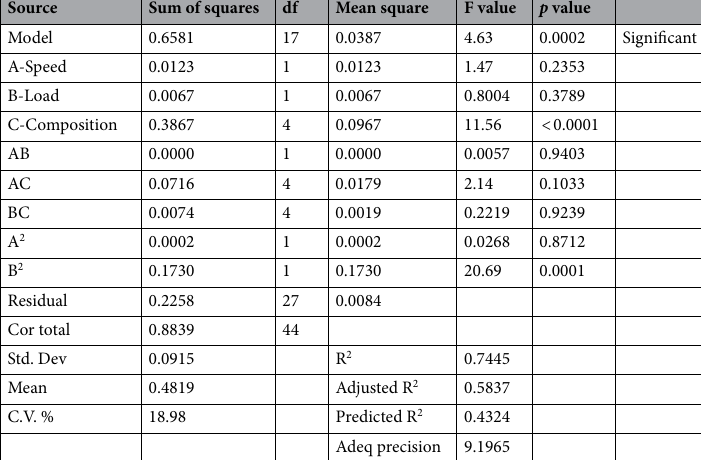
Table 6. ANOVA and summary of fit statistics for response 2 (specific wear rate).